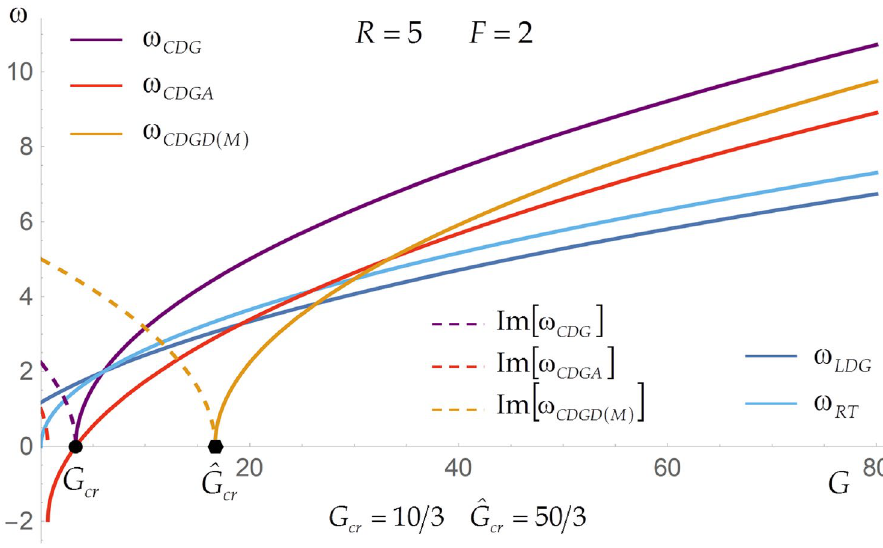
Fig. 5 Dependence of the growth-rate(s) on the accelera- tion at some parameters